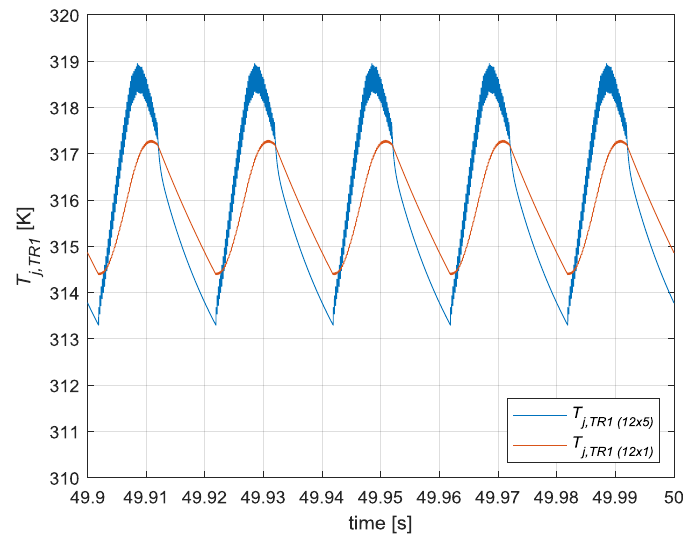
Figure 26. Zoom of the evolution of T R1 semiconductor junction temperature with the individual 5-stage 12 × 5 thermal model and simplified single stage 12 × 1 thermal model.